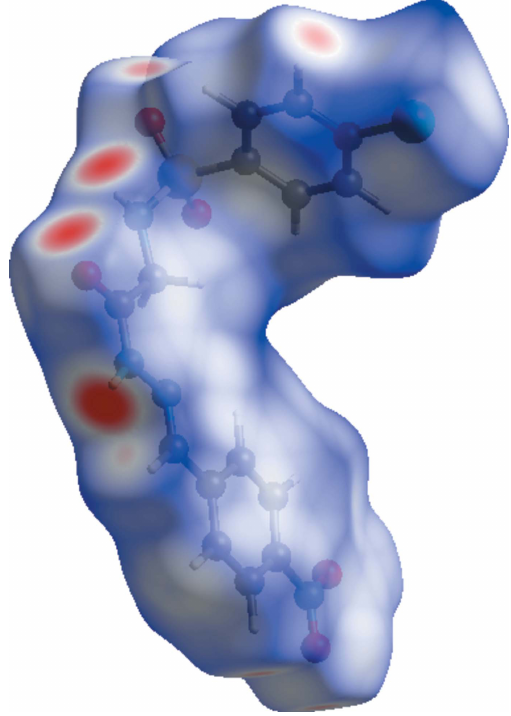
Figure 5 View of the Hirshfeld surface mapped over d norm .